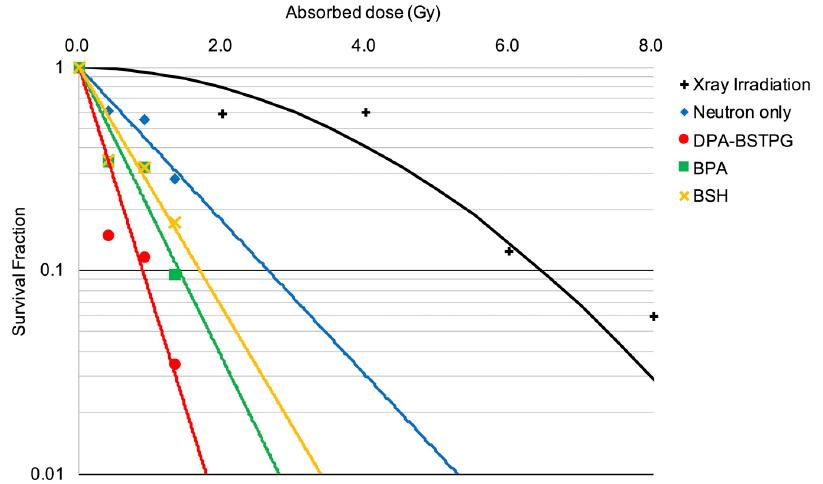
Figure 2. The absorbed doses required to obtain at survival fraction (SF) = 0.1 were 6.45 Gy in